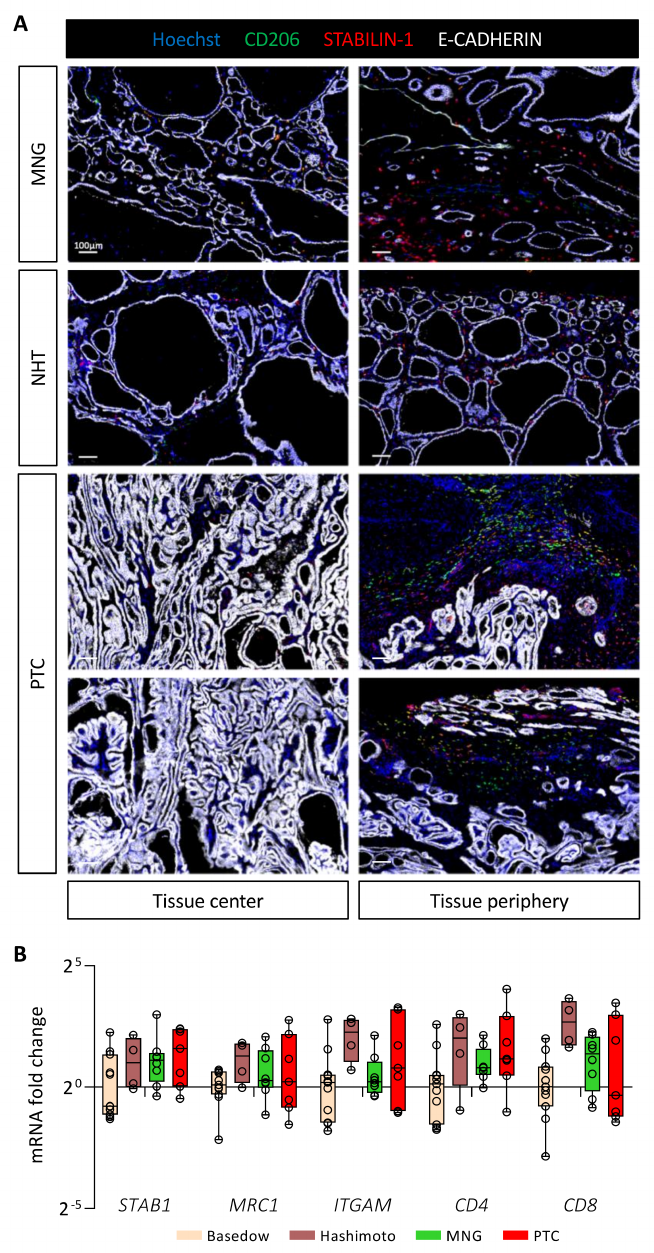
Figure 6. STABILIN-1+ cells are found in benign and malignant human thyroid tumors. ( A ) Im- munohistofluorescence of CD206 (green), STABILIN-1 (red), and E-CADHERIN (white) on sections of human thyroid conditions: multinodular goiter (MNG), healthy tissue neighboring PTC (NHT), and papillary thyroid carcinoma (PTC). For each condition, a picture in the center and the periphery of the tissue is shown. ( B ) RT-qPCR analyses of different immune cell population marker genes on different thyroid pathologies. mRNA fold changes are normalized to the RPL13A expression and compared to Basedow disease. Data are expressed as the mean ±